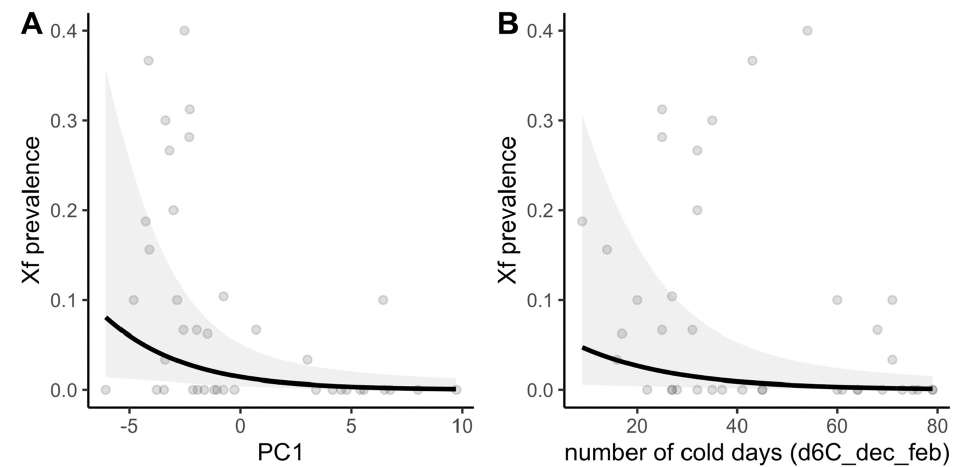
Figure 3. Correlation between X. fastidiosa prevalence in vectors and climate. ( A ) GLMM1: Prevalence and sampling site scores on PC1 of the PCA performed on climate variables. ( B ) GLMM2: Prevalence and number of days in December to February (d6C_dec_feb) with minimal daily temperature <6 °C. Points are raw data, lines are regression curves from GLMMs, and grey ribbons are 95% confidence envelopes.